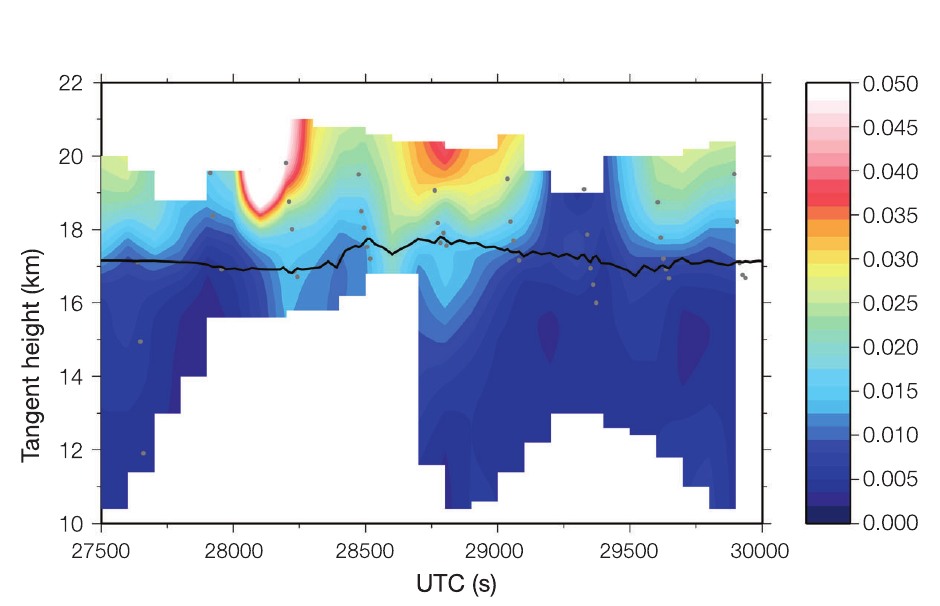
Fig. 18. Two dimensional map of the ratio between the difference of the two polarisation components and the horizontal component measured by the standard Martin-Puplett confi guration